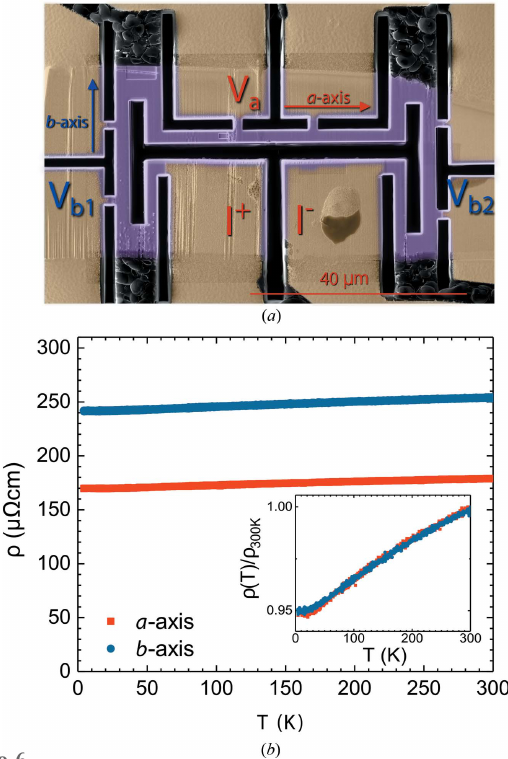
Figure 6 Electrical resistivity anisotropy measured on a micro-fabricated single crystal of Sr 2 Pt 8 (cid:2) x As (purple in the SEM image). ( a ) The starting lamella were extracted from the single crystal following the identified crystal- lographic direction from X-ray diffraction. Electrical resistivity is measured along the a and b axes as a function of temperature. For the b axis, the voltage drop was measured at two positions with different geometrical factors ( V b1 , V b2 ). The current flows between the two leads (marked as I + and I (cid:2) ). Colours are added to identify the micro-fabricated crystal (purple) and the sputtered gold top contacts (yellow). The crystal is fixed on a sapphire substrate by a drop of epoxy glue. ( b ) A nearly temperature-independent electrical resistivity was observed along both crystallographic directions. The resistivity is higher for current flow perpendicular to the layers. In the inset, resistivity curves normalized to their value at 300 K show identical temperature dependences.